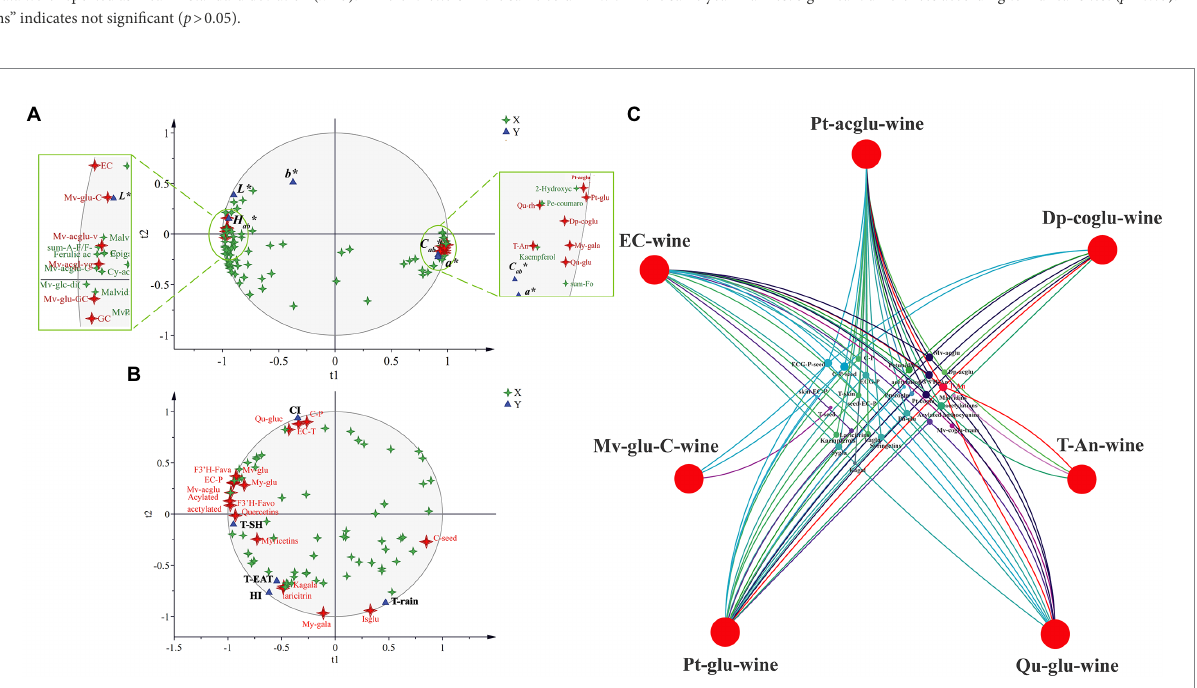
FIGURE 5 Partial least squares regression (PLSR) analysis for all wines based on CIELAB parameters and flavonoid compounds (A) ; PSLR analysis for grapes based on flavonoid compounds and environmental factors (B) ; PSLR analysis for all wines based on key flavonoid compounds affecting wine color parameters and flavonoids in grapes (C) . The abbreviated names of the substances in the figure are shown in Supplementary Tables S6,